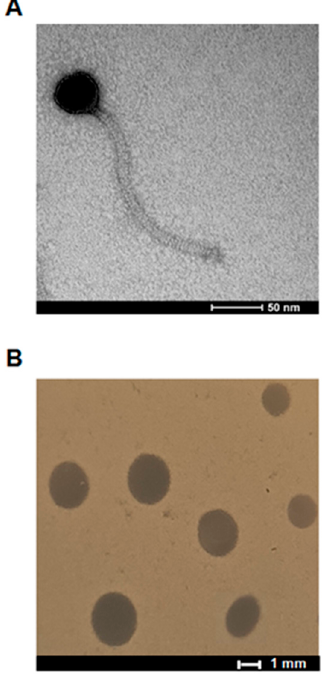
Figure 1. Morphologies of bacteriophage vB_EfaS-271 virion ( A ) and plaques formed by this bacteriophage on the lawn E. faecalis 271 strain using double-agar plates ( B ).